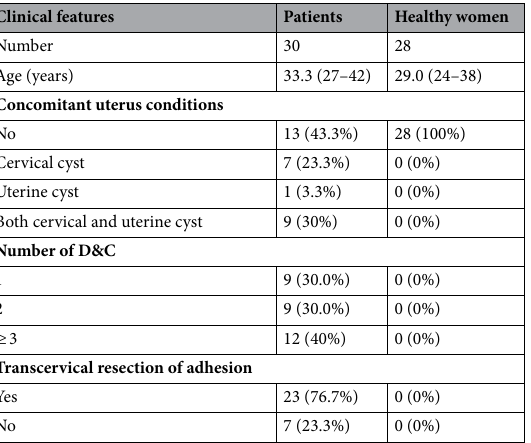
Table 1. The clinical demographics of patients with endometrial fibrosis and healthy women. Data are number (percentage) or mean (range). D&C dilation and